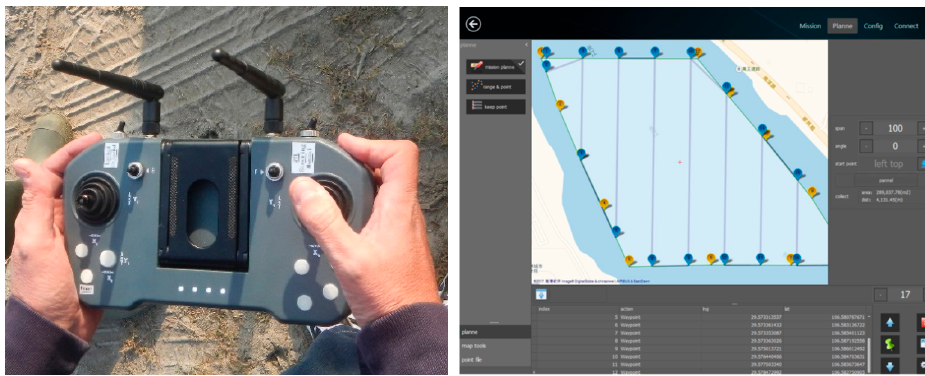
Figure 3. Console and PC software interface for remote control.